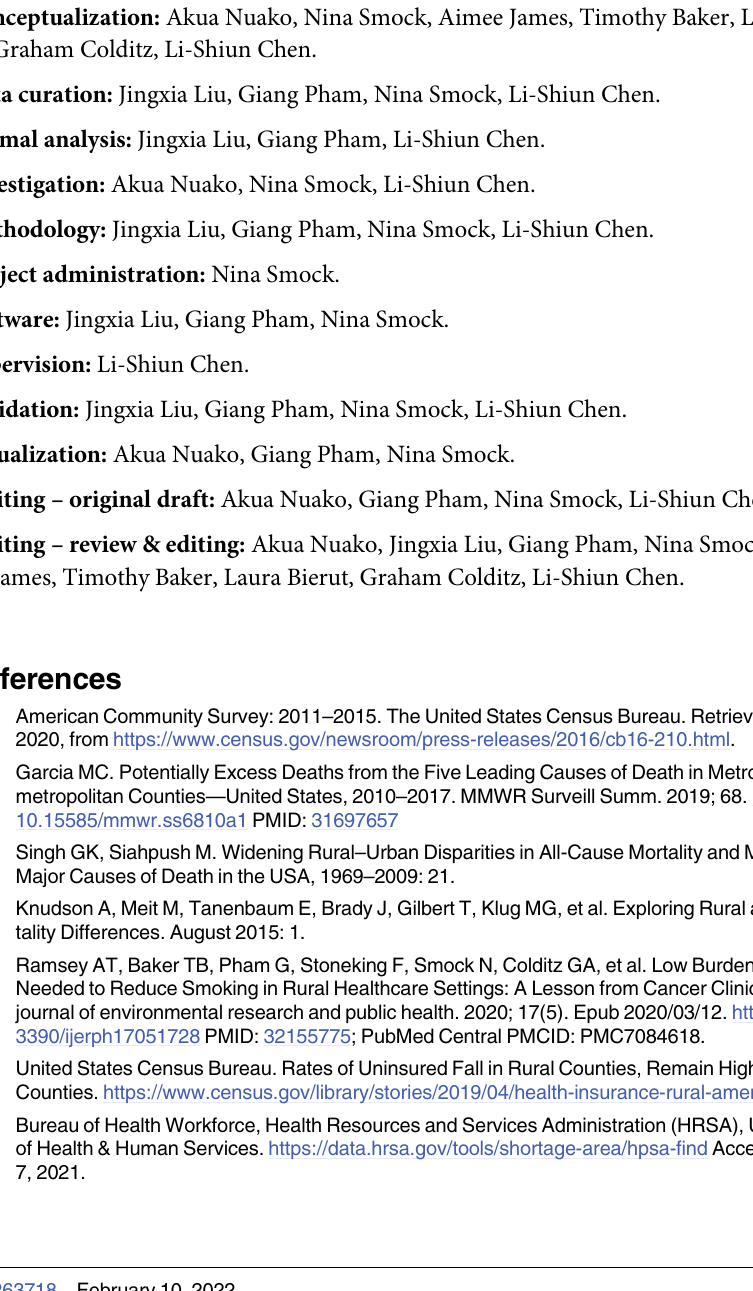
S4 Table. Healthcare utilization a across patient characteristics including Elixhauser. S5 Table. Association of patients characteristics and primary care utilization: Multivariate analyses a,b . S6 Table. Association of patients characteristics and specialty care utilization: Multivariate analyses a,b